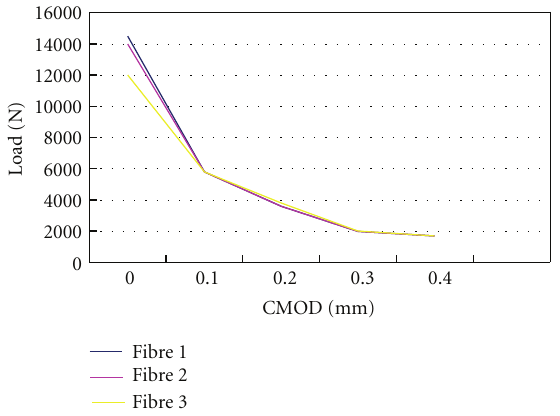
Figure 8: P-CMOD for concrete with 2kg long fiber. strain gauging unit, and YEW-200A dropping electrode compression-testing machine (Tables 2 and 3).